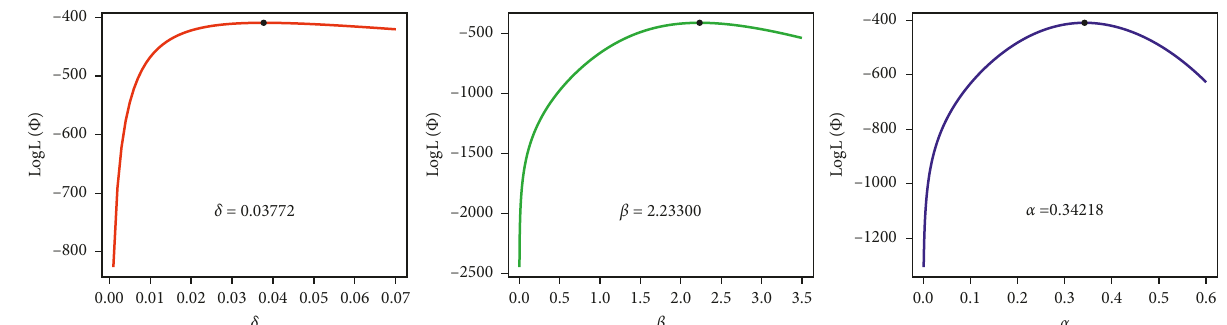
Figure 11: The profiles of the log LF of the NFLog-Wei distribution using Data 3.